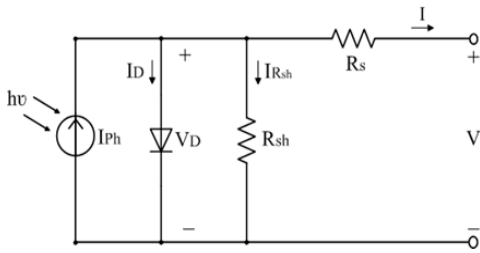
Figure 8. Solar cell equivalent circuit.